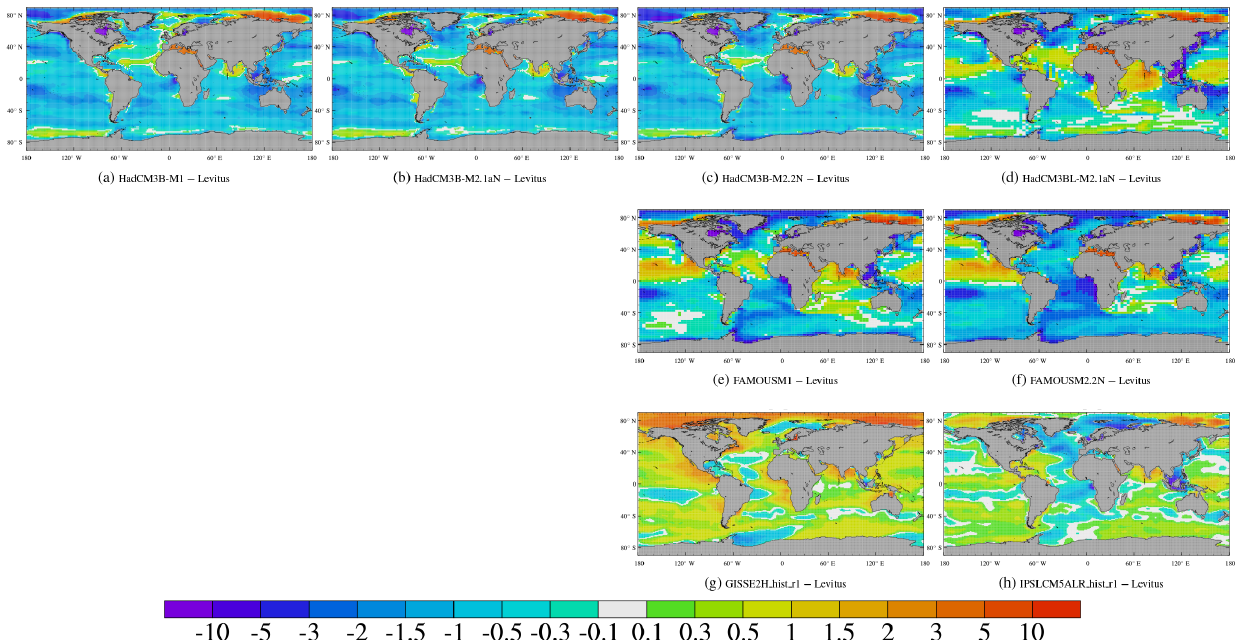
Figure 7. As Fig. 6 but showing the differences in sea surface salinity (in gkg − 1 ) between models and observations. (a) HadCM3B-M1, (b) HadCM3B-M2.1a, (c) HadCM3B-M2.2, (d) HadCM3BL-M2.1a, (e) FAMOUS-M1, (f) FAMOUS-M2.2, (g) GISS-E2-H, and (h) IPSL- CM5A-LR. The observational dataset is the Levitus World Ocean Atlas (2009) (Antonov et al., 2010). Model output is regridded to the same resolution of the